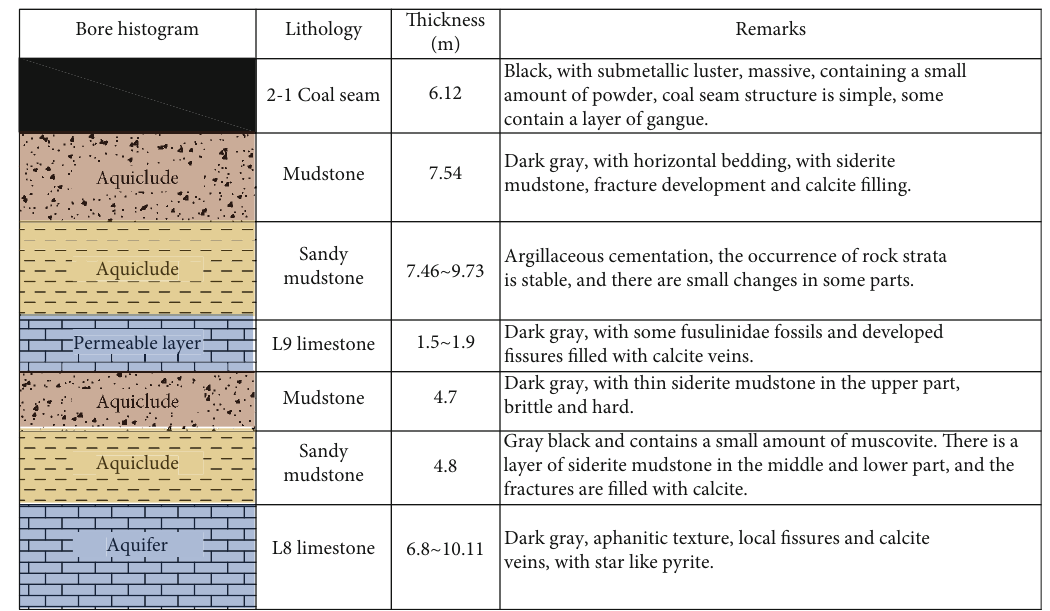
Figure 6: The comprehensive histogram of rock strata in coal seam.